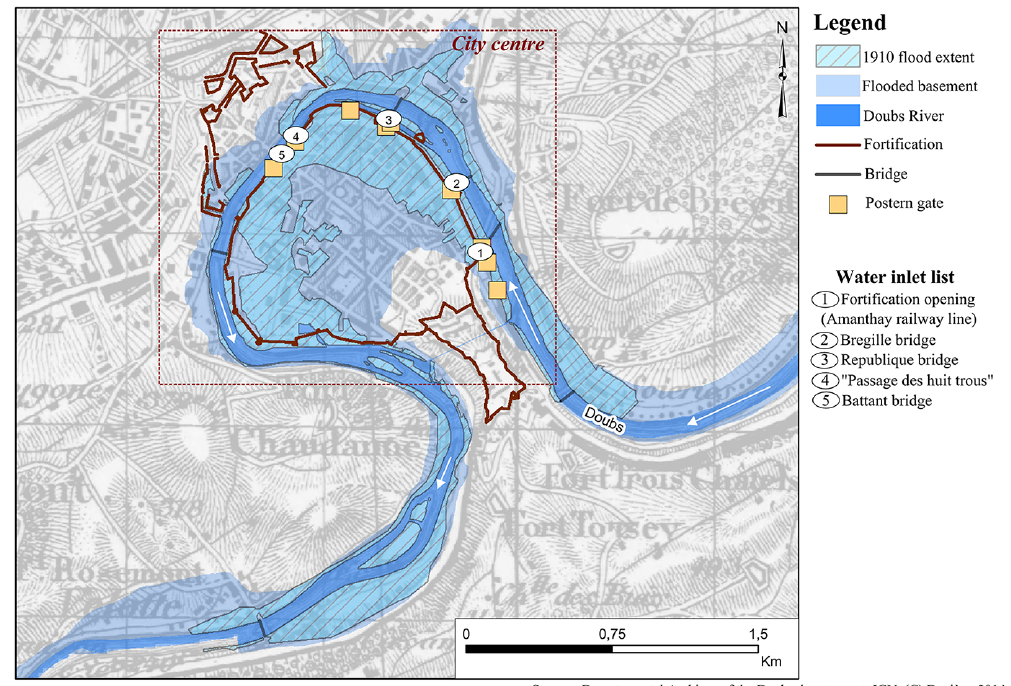
Figure 4. Old Besançon city centre with characteristic water inlets during the flood event on 17–21 February